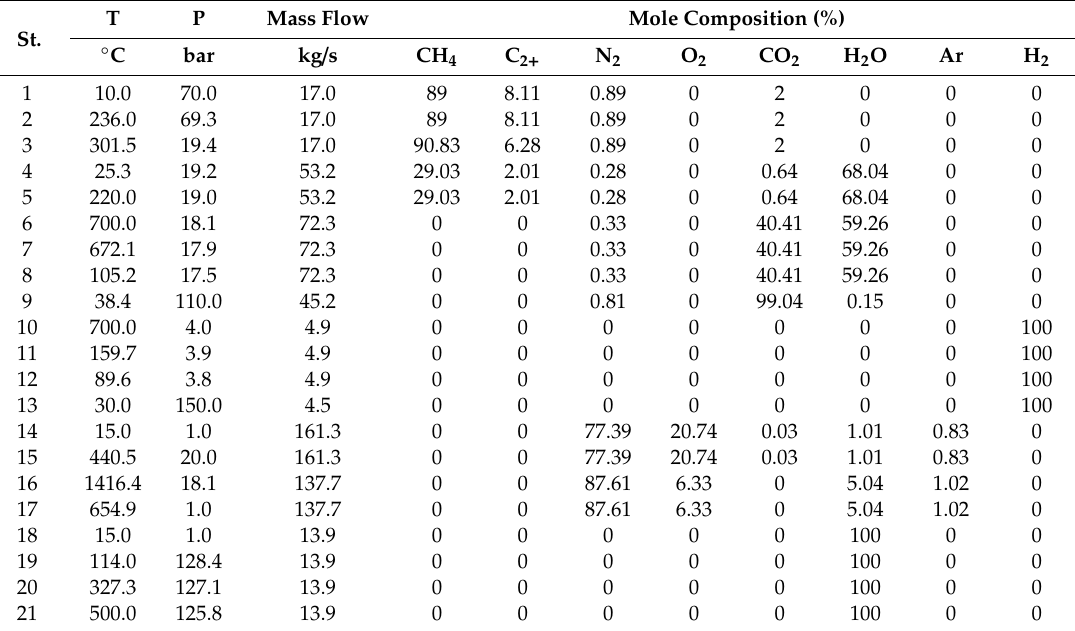
Table 3. Stream data of case 4 with 2P-HX (mainly H 2 production) in Figure